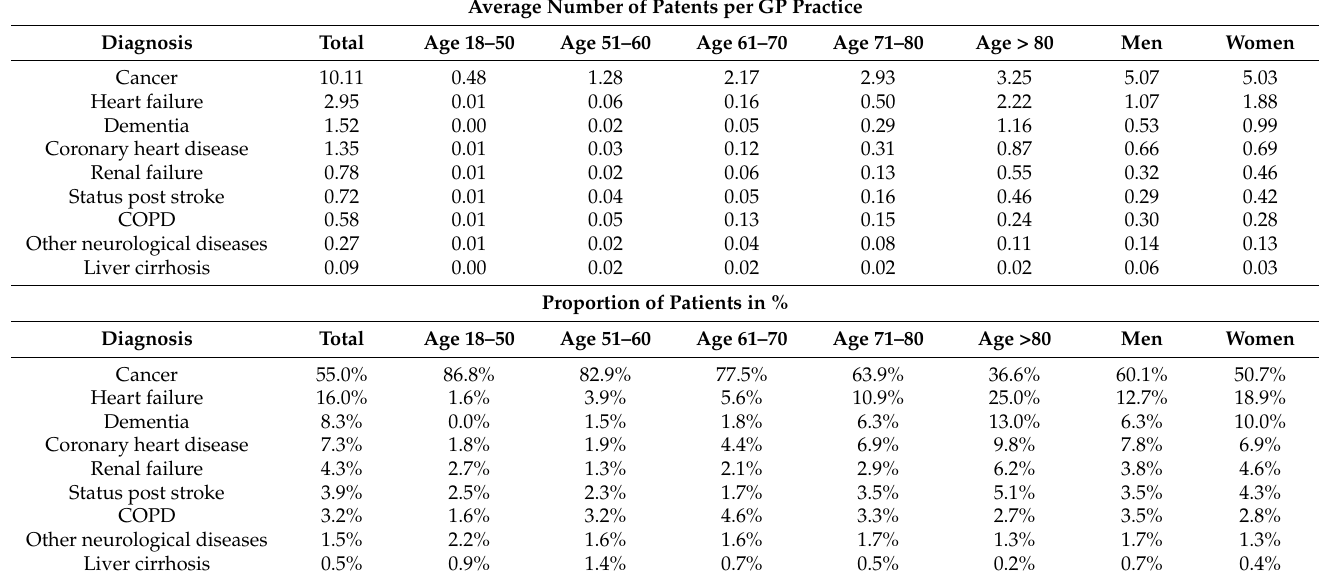
Table 1. Underlying medical diagnoses of patients receiving palliative care in Germany between 2018 and 2021 stratified by sex and age.